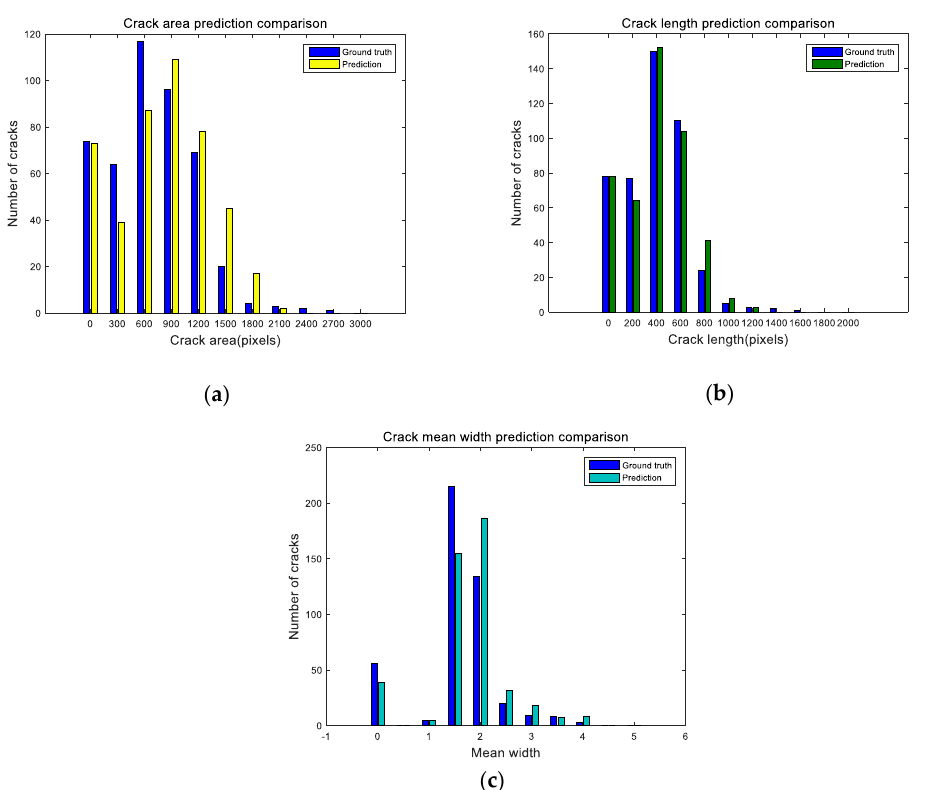
Figure 13. Histogram of crack measurement using U-CliqueNet: (a) crack area, (b) crack length, (c) crack mean width.